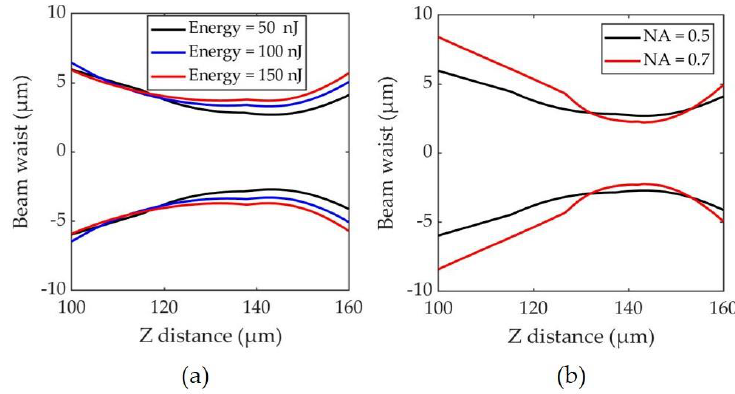
Figure 2. Beam waist evolution for silicon ( a ) at different pulse energy for 0.5 NA and ( b ) for different NA values at 50 nJ input pulse energy.